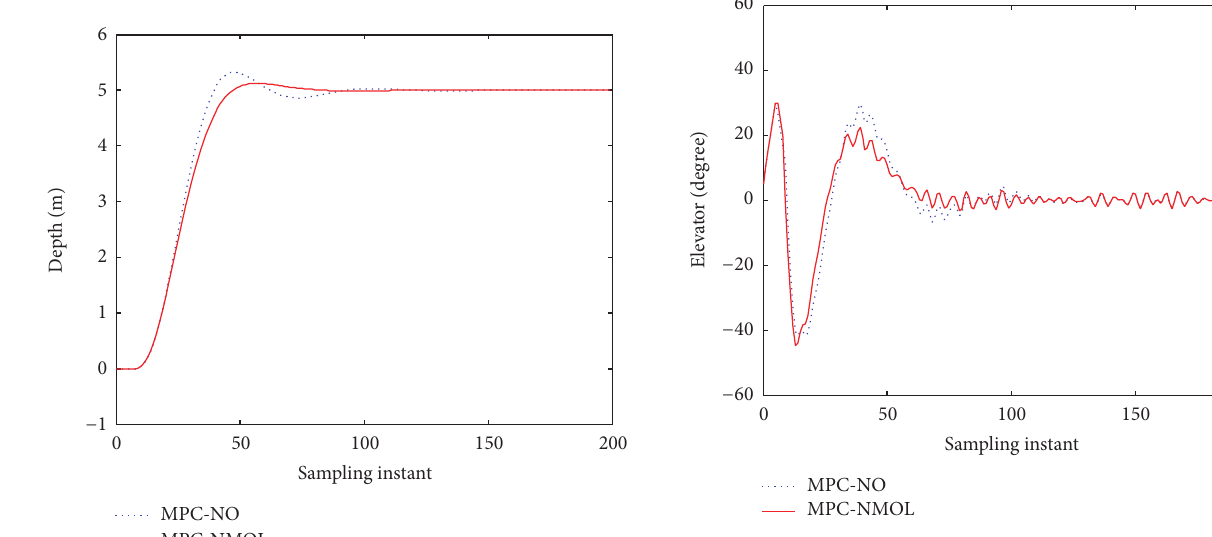
Figure 9: Comparison of elevator deflection angle with